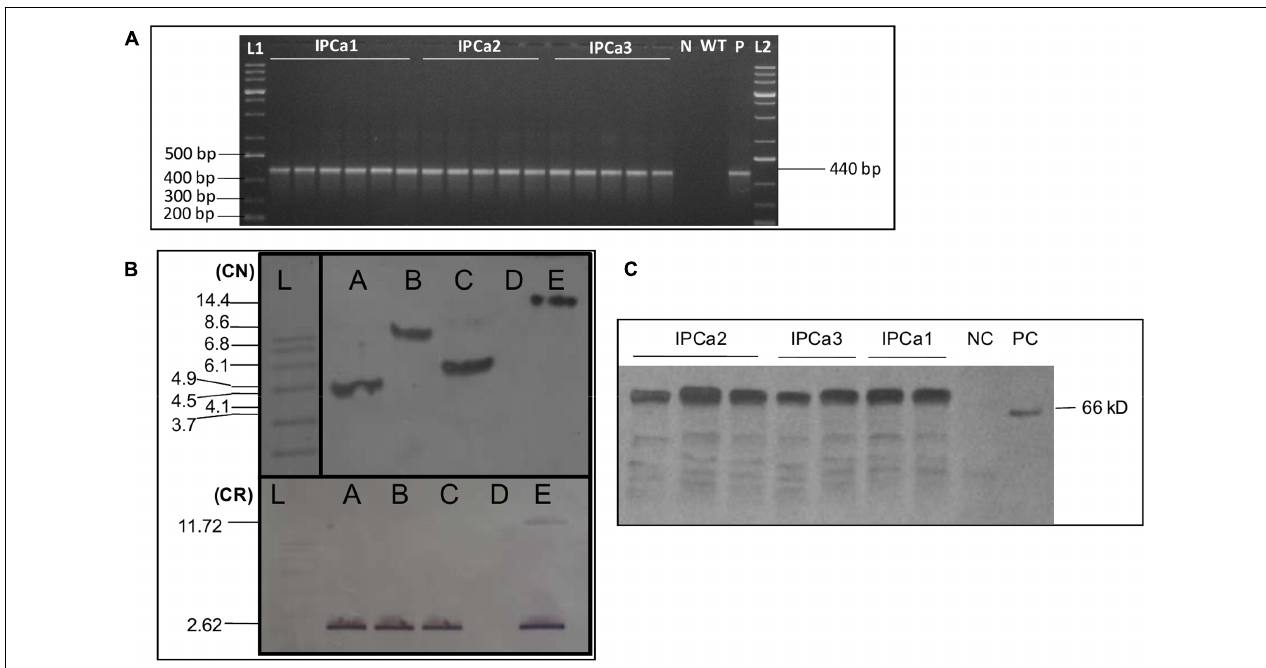
FIGURE 1 | Molecular analysis of three transgenic chickpea lines. (A) PCR analysis of transgenic chickpea progenies. Lanes are as follow, L1: 1 kb DNA Ladder (Thermo Scientific, United States); IPCa1 (Lanes 1–6): progenies from IPCa1; IPCa2 (Lanes 7–11): progenies from IPCa2; IPCa3 (Lanes 12–16): progenies from IPCa3; N: no template control; WT: wild-type (non-transgenic line); P: positive control (Plasmid); L2: 1 kb DNA ladder (Thermo Scientific, United States). (B) Southern blot analysis of three events using cry1Aabc specific probe in T 4 generation. Copy number (CN) identification using Hind III. Cassette release (CR) ( Cry1Aabc gene) in transgenic lines using Hind III and Eco RI. Lanes are as follow, L: DIG labeled mol. wt. marker (Roche Diagnostics GmbH, Mannheim, Germany); A: IPCa1 event; B: IPCa2 event; C: IPCa3 event; D: negative control (non-transgenic DCP92-3); E: positive control. (C) Western blot analysis (T 4 Generation) [Lanes 1–3: